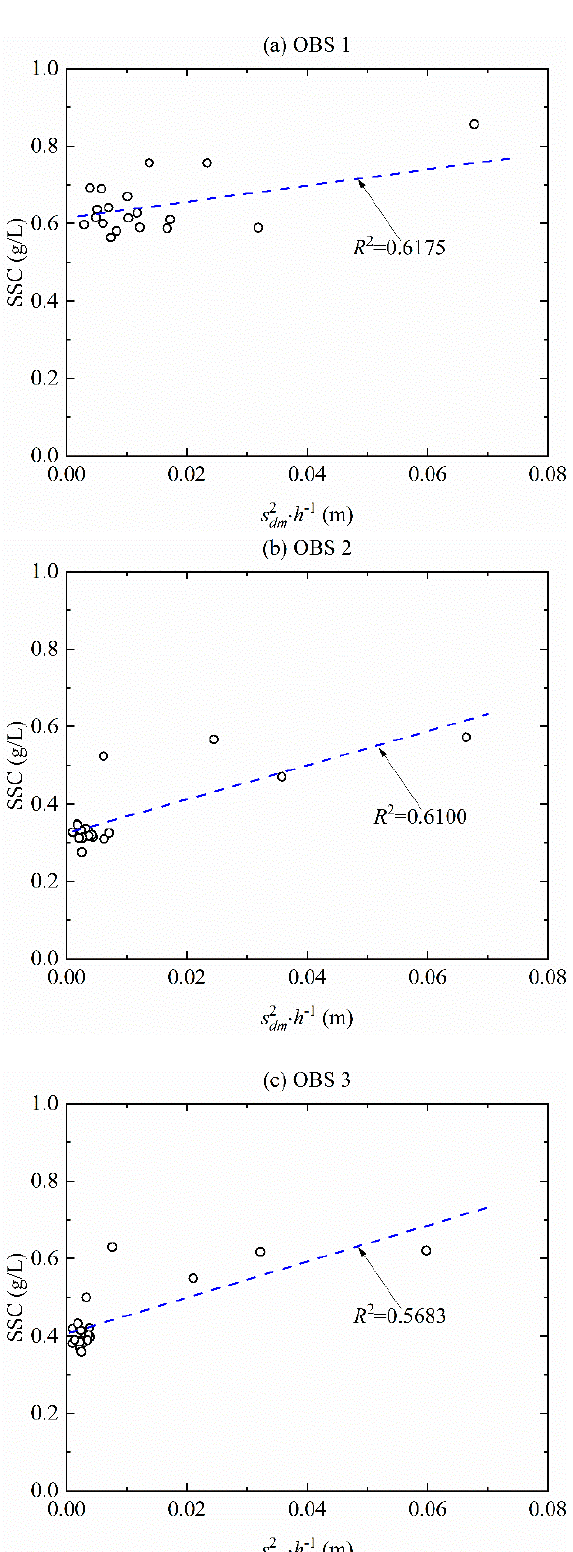
Figure 8. Relationship between the maximum SSC and the maximum ship-induced drawdown height ( 𝑠 (cid:3031)(cid:3040) ) at the different locations.